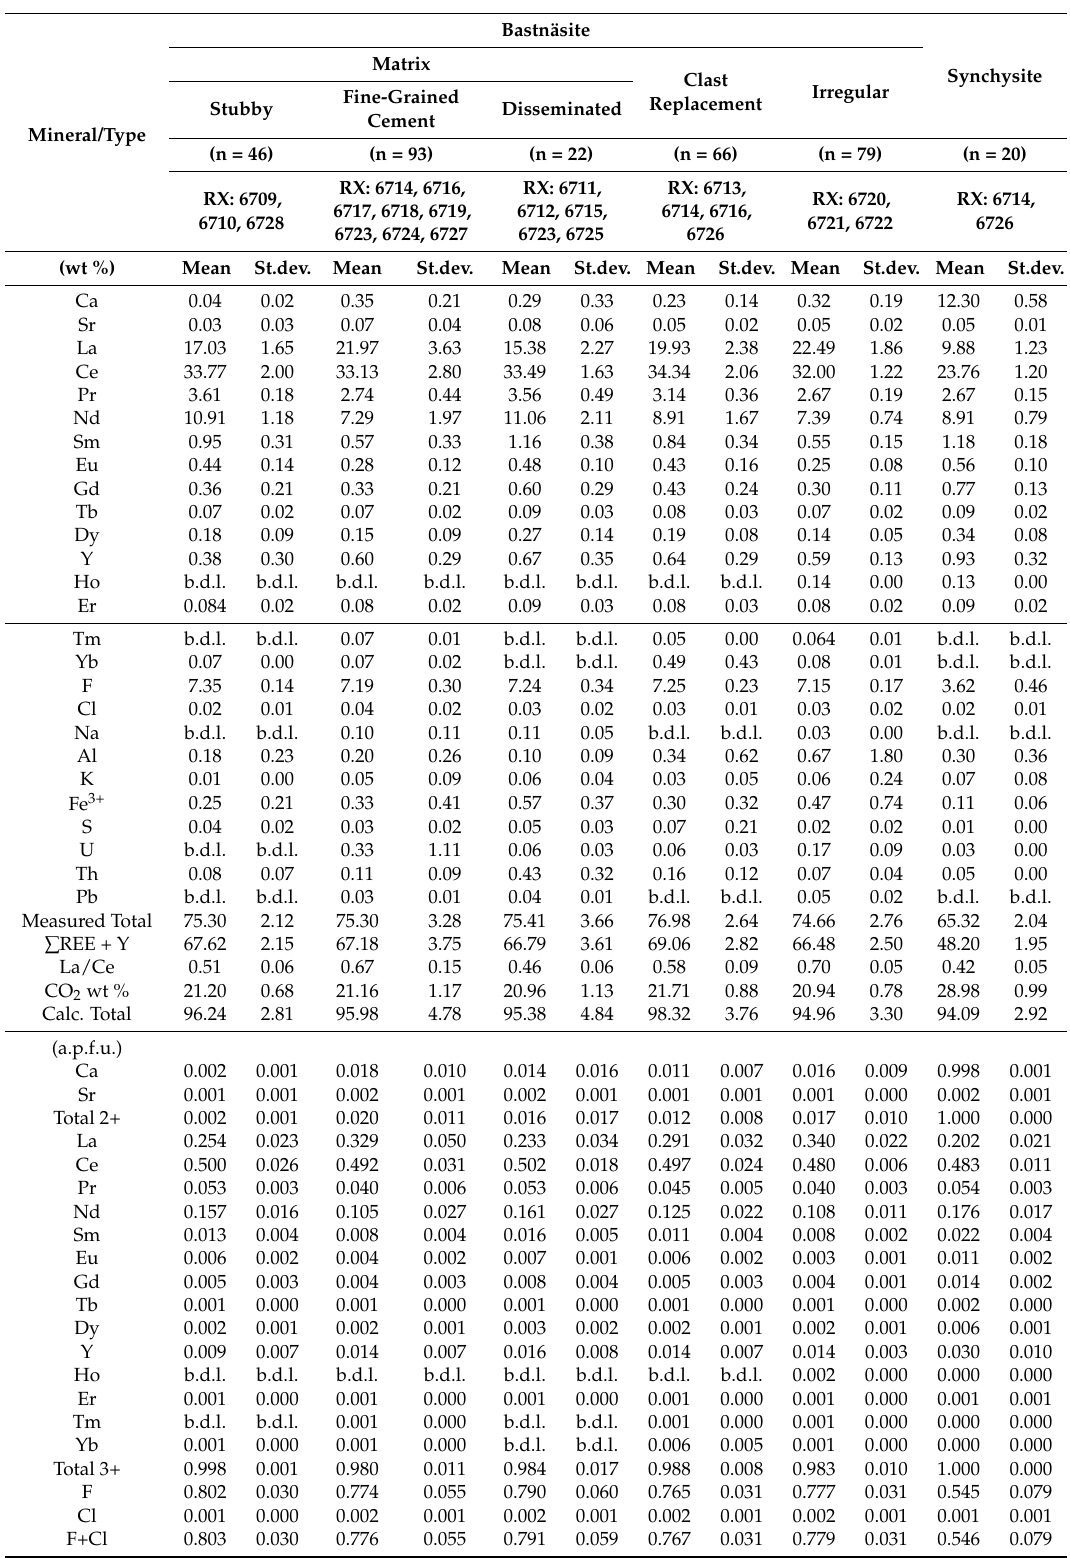
Table 2. Summary of EPMA compositional data for bastnäsite and synchysite. Average and standard deviations of major mineral groupings in weight percent (wt %) and atoms per formula unit